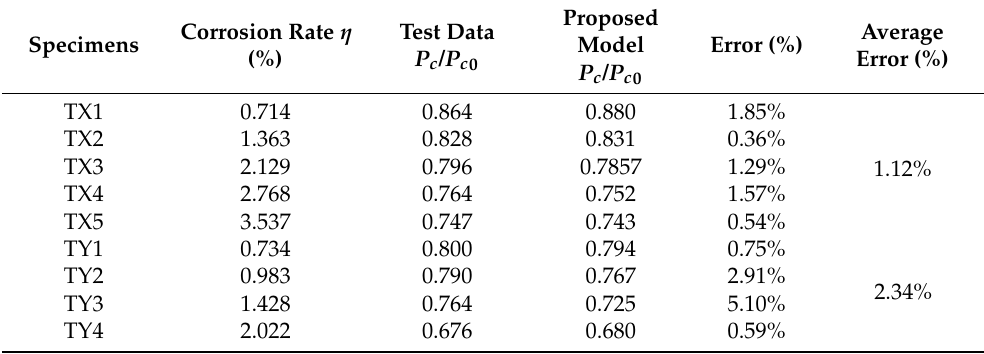
Table 9. Comparison of the PF-HSB after corrosion between the proposed model and test